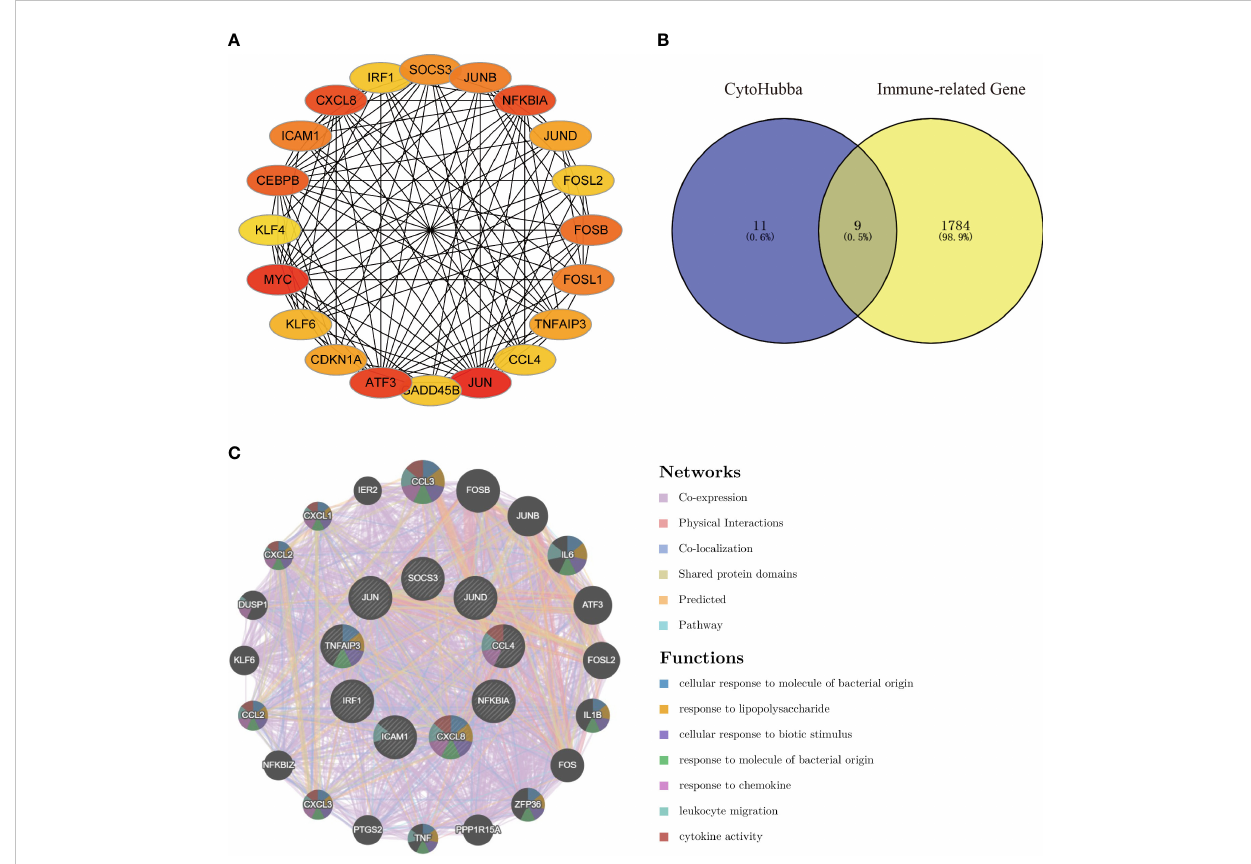
FIGURE 5 Venn diagram and co-expression network of the hub genes. (A) The top 20 genes were obtained by cytoHubba ’ s Degree algorithm and used them for network gene clustering identi fi cation. (B) Venn diagram of immune-related hub genes. (C) Immune-related hub genes and their co-expression genes were analyzed by